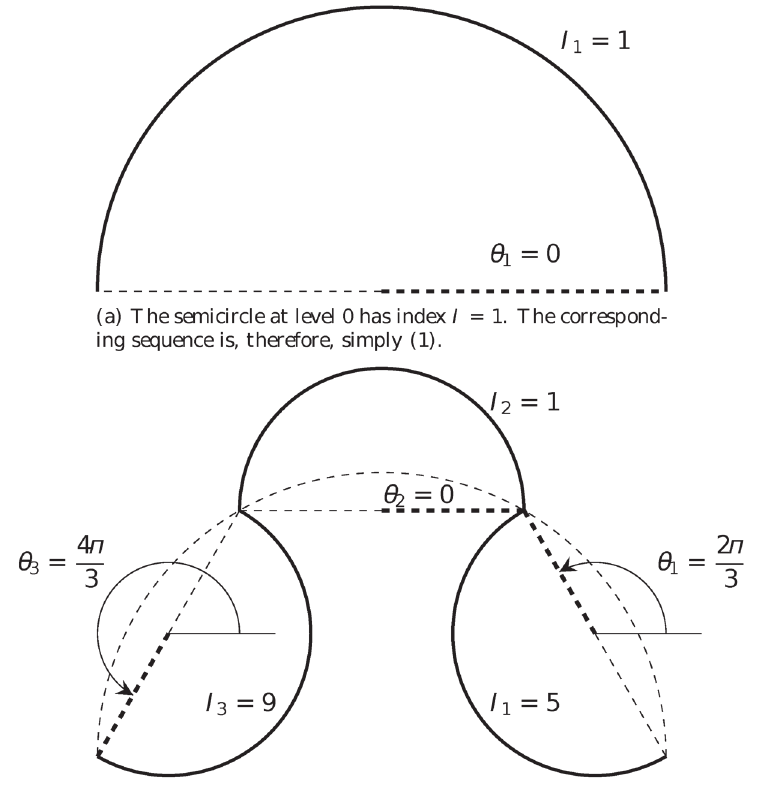
Fig 5. Sequences associated with the arrowhead fractal at different levels of construction. The rule is: α = π , n = 3 and ω = (1, − 1, 1). The relation between the angle θ i and the index I i is given by Eq. (1).